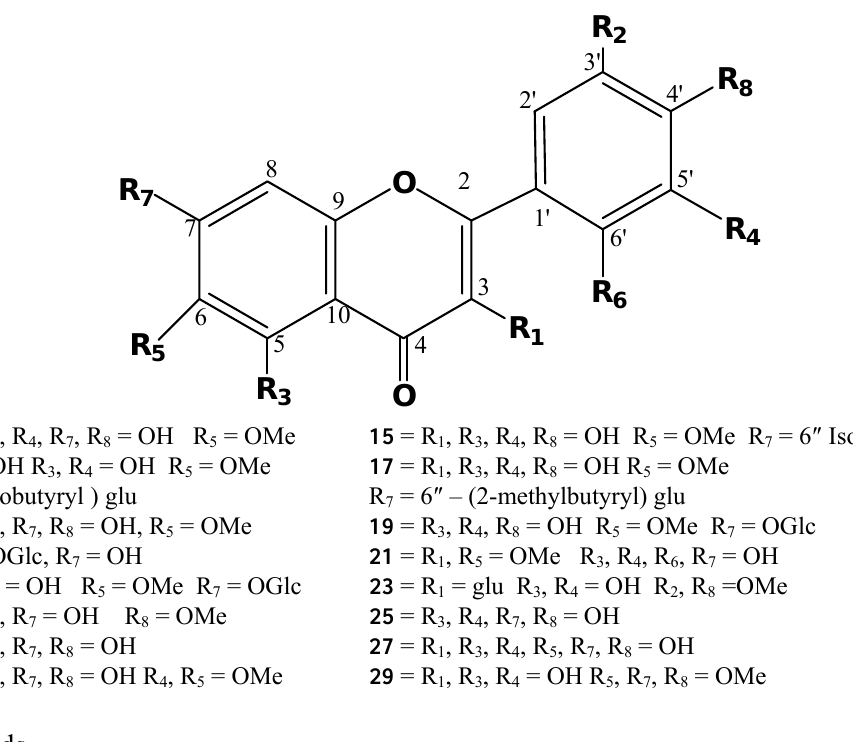
Figure 4. Flavonoids from I. britannica